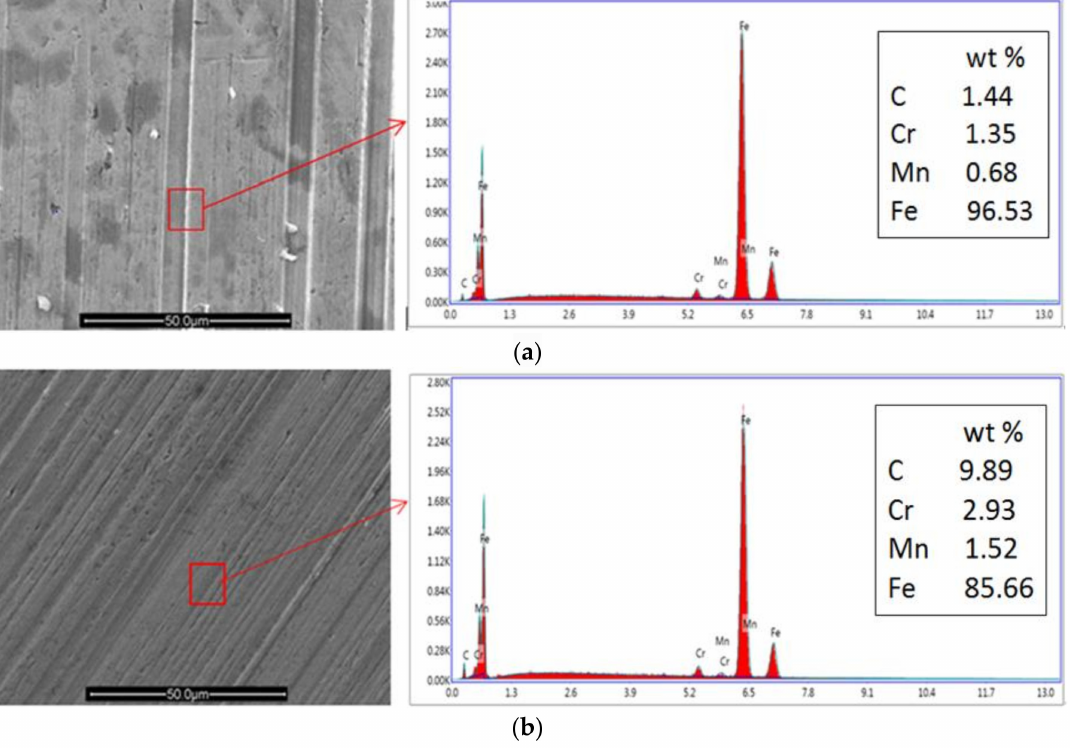
Figure 6. SEM micrographs of the friction surfaces of the ball and the corresponding energy dispersive spectroscopy analysis: ( a ) Lubricated with 5CB; ( b ) lubricated with 5CB+0.15 wt.% G